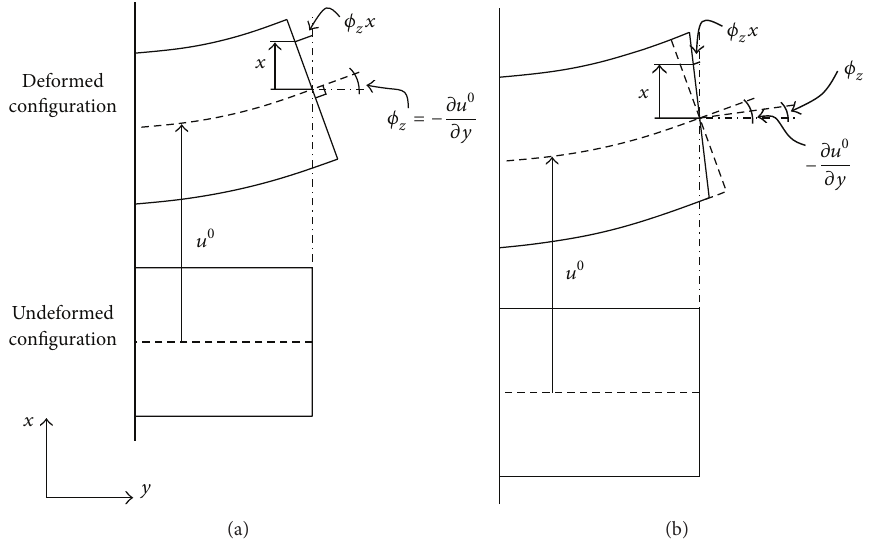
Figure 2: Differences between Euler-Bernoulli (a) and Timoshenko (b) beam theories.